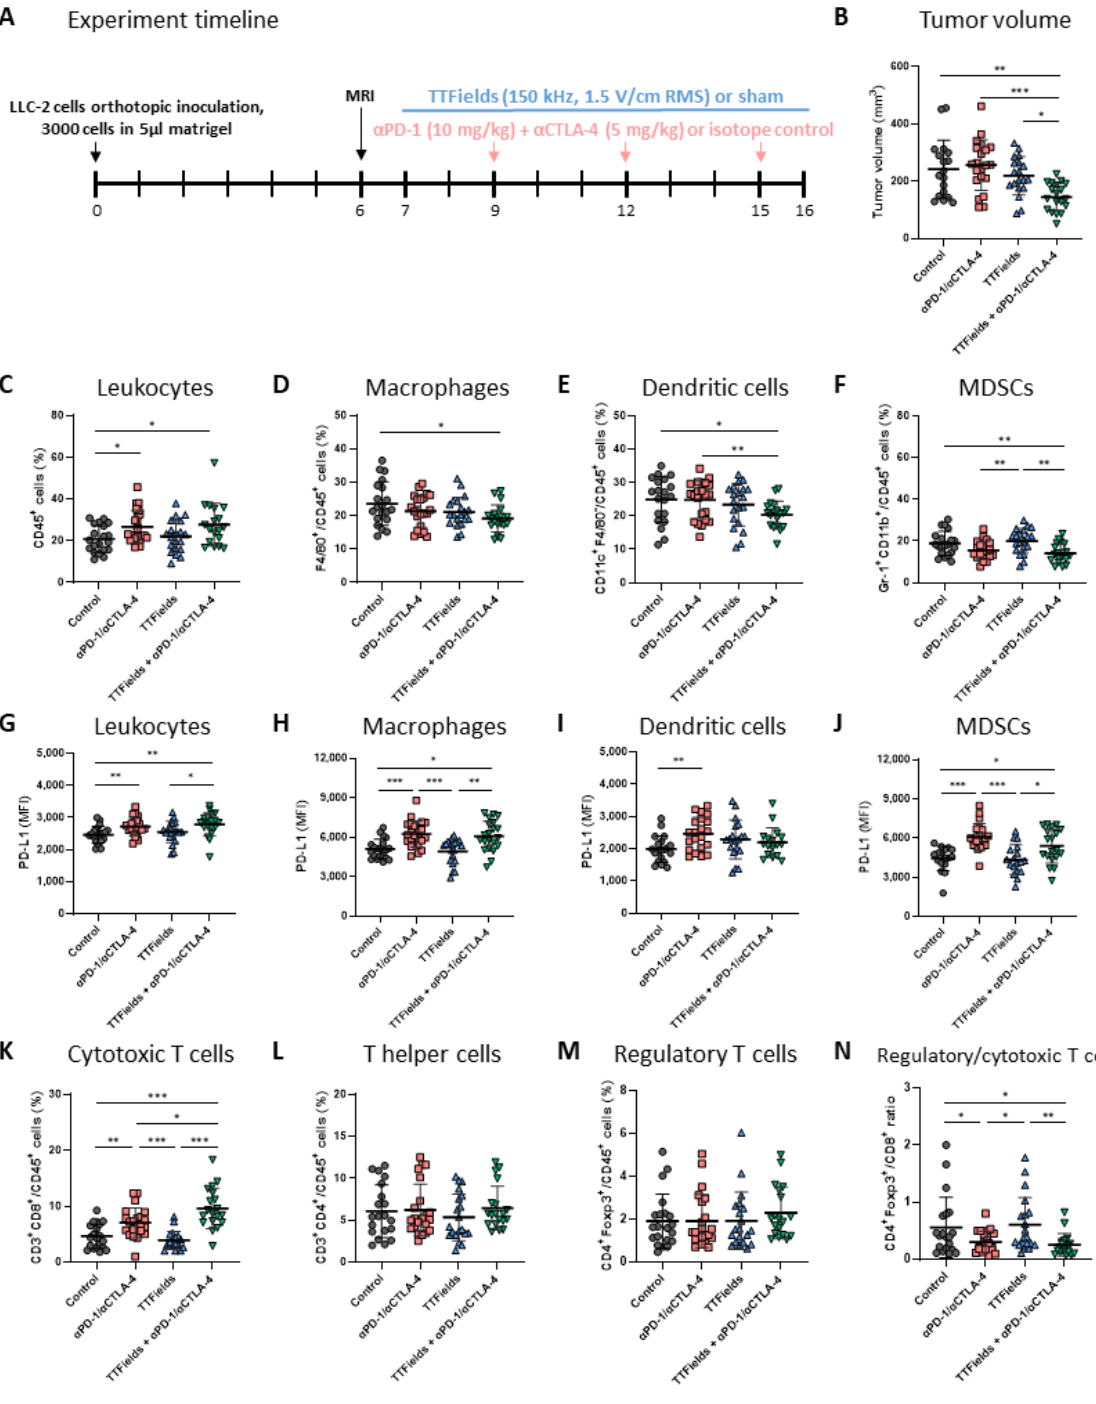
Figure 2. Concomitant TTFields with anti-PD-1/anti-CTLA-4 reduced tumor volume and increased tumor infiltration of cytotoxic T cells. ( A ) Mice were orthotopically inoculated with LLC-2 Lewis